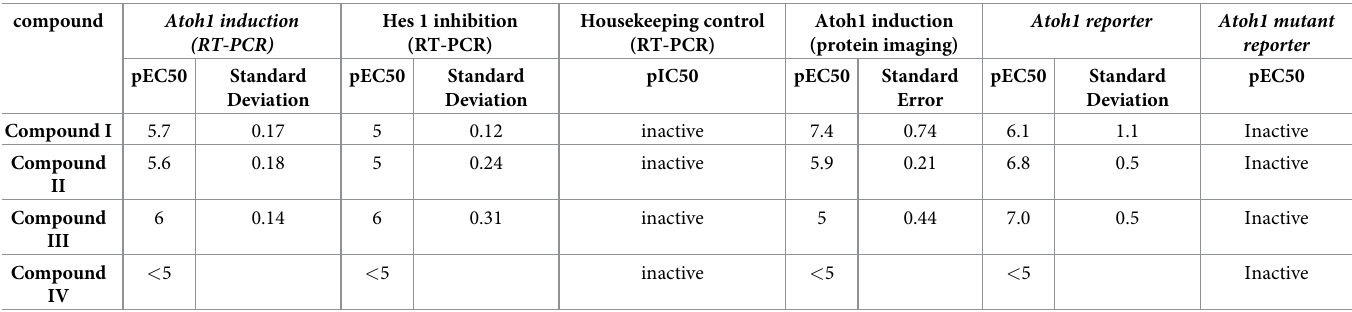
Table 1. Summary of γ -secretase inhibitor activities of in Atoh1 and Hes1 gene expression (RT-qPCR), Atoh1 protein imaging and Hes1 promoter driven NanoLuc luciferase reporter assays. Results are listed as pEC50 ( Atoh1 induction in RT-qPCR, imaging and reporter) or pIC50 ( Hes1 inhibition in RT-qPCR) values. The value for RT-PCR, and reporter assay represent the average and the standard deviation of at least 3 independent experiments. The standard error of the imaging assay is based on calculation from the dose response. compound Atoh1 induction